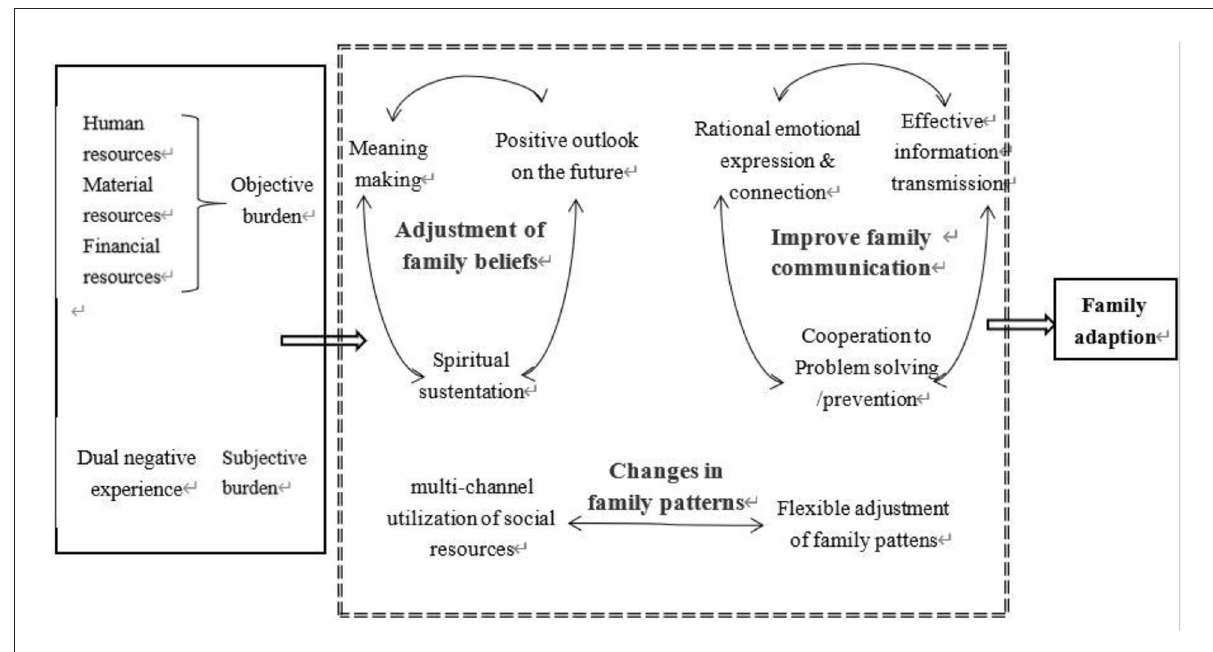
FIGURE1 Dyadic cooperative coping and family resilience adjustment